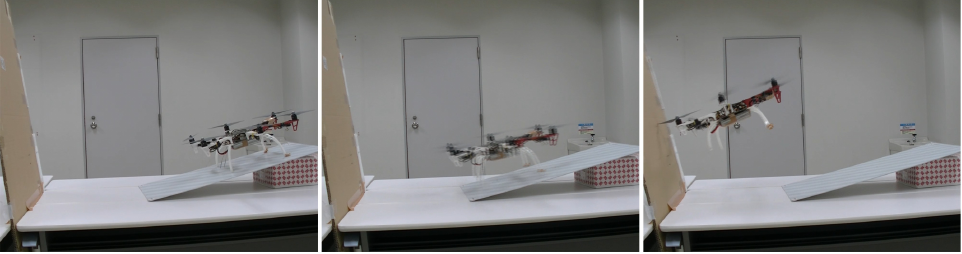
Figure 9. Conventional UAV take-off from a sloped surface resulting in sliding and crashing into a